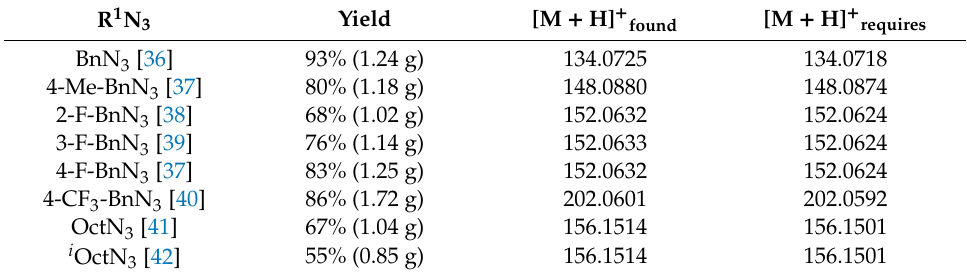
Table 4. Yield and mass data for the organic azides